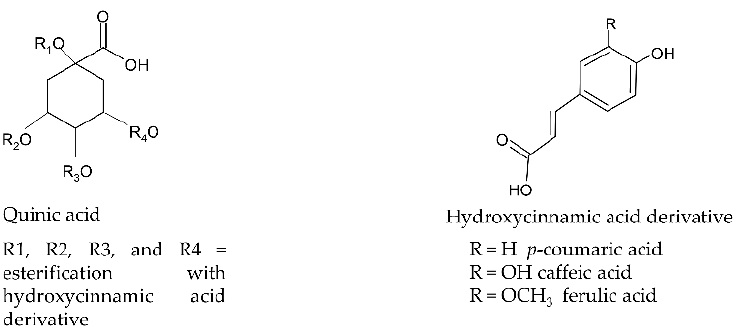
Figure 1. General structures of the main chlorogenic acids (esters between quinic acids and hydroxycinnamic acid derivatives).